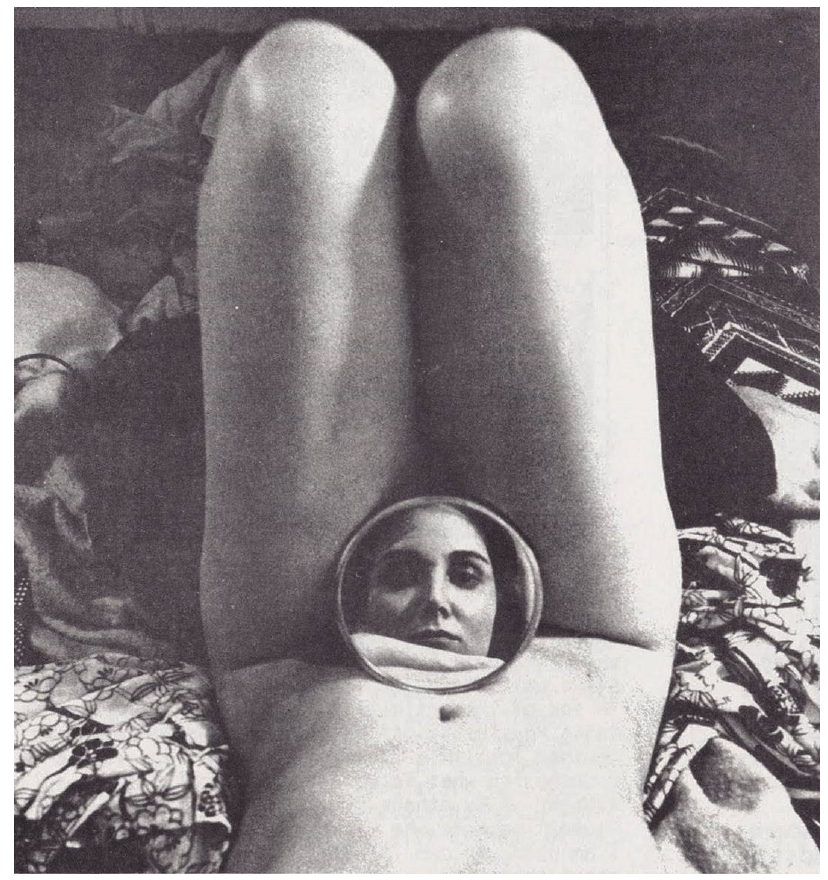
Figure 3. Self-Portrait, 1981. Photograph ©1981 Armen Susan Ordjanian, All rights reserved.